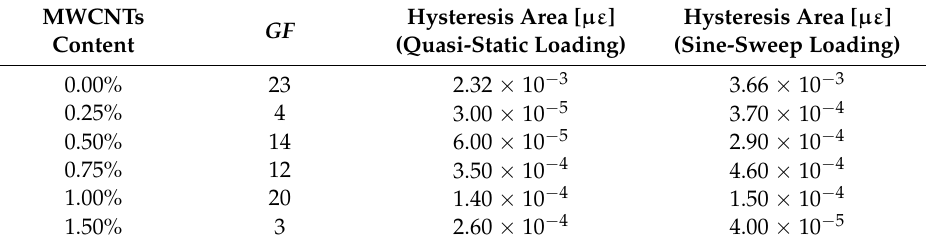
Table 4. Summary of the strain sensitivity analyses conducted on nanocomposite concrete specimens, including Gauge Factors (GFs), and the hysteresis areas of the relative change in electrical resistance versus applied strain curves, considering both quasi-static and sine-sweep dynamic compression